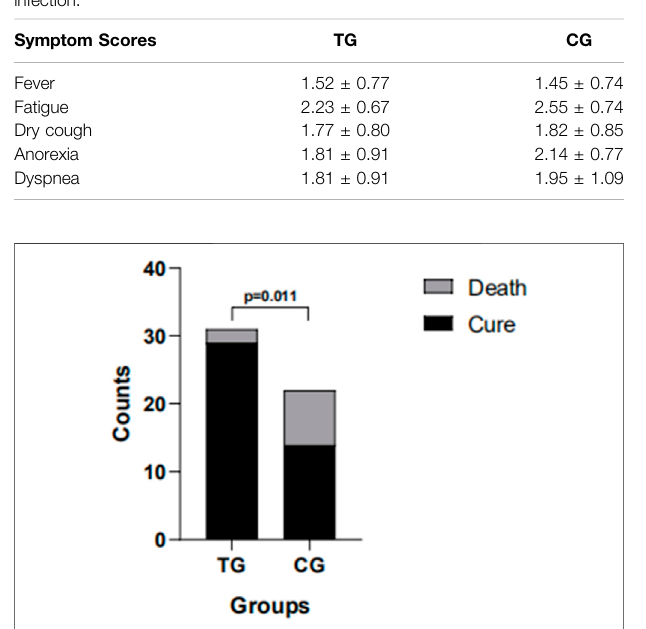
FIGURE 1 | In the treatment group (TG), 29 patients recovered and two died; in the control group (CG), 14 patients recovered and eight died.